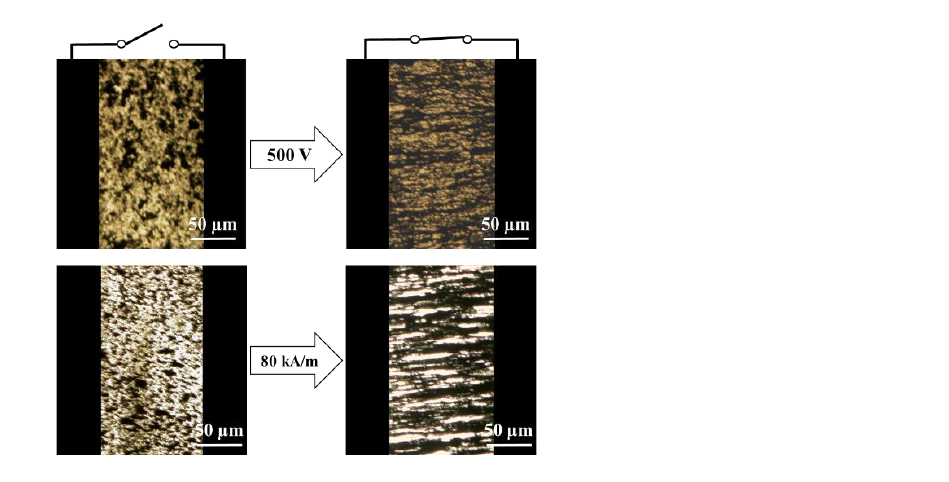
Figure 6. OM images of the ZnFe 2 O 4 /PMA particle-based smart fluid under E ( top ) and H ( bottom ).